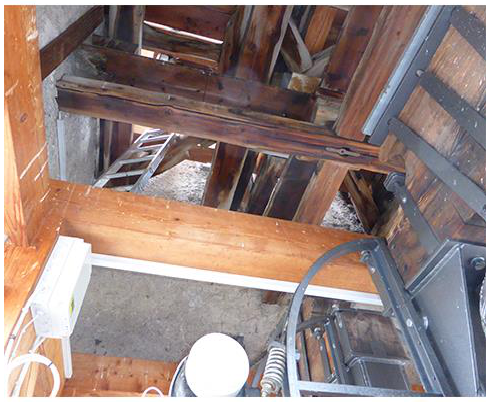
Figure 3. View of inside from B floor